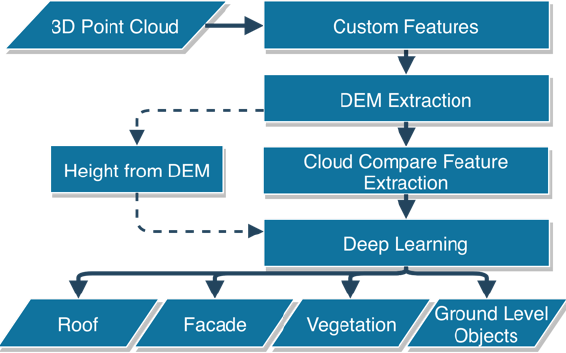
Figure 3. The proposed approach to classify aerial photogrammetric point clouds using a deep learning